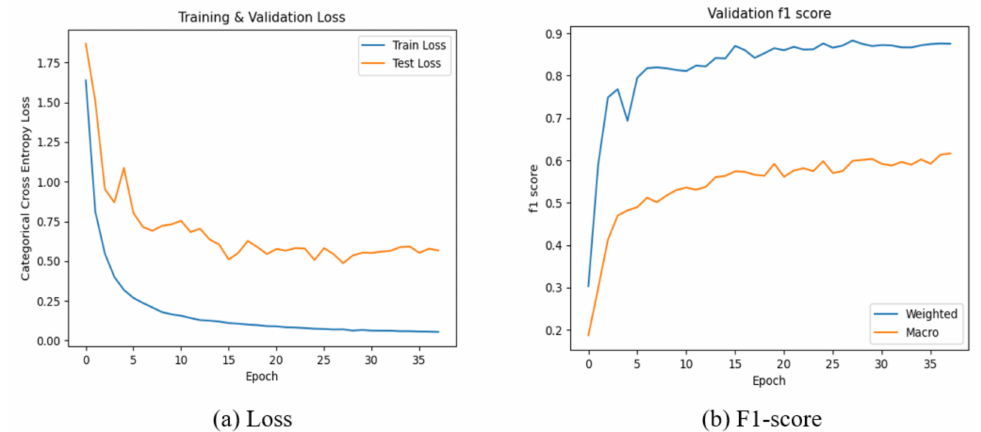
Figure 8. ( a ) Training and validation loss, ( b ) F1-score on training dataset without NULL class.